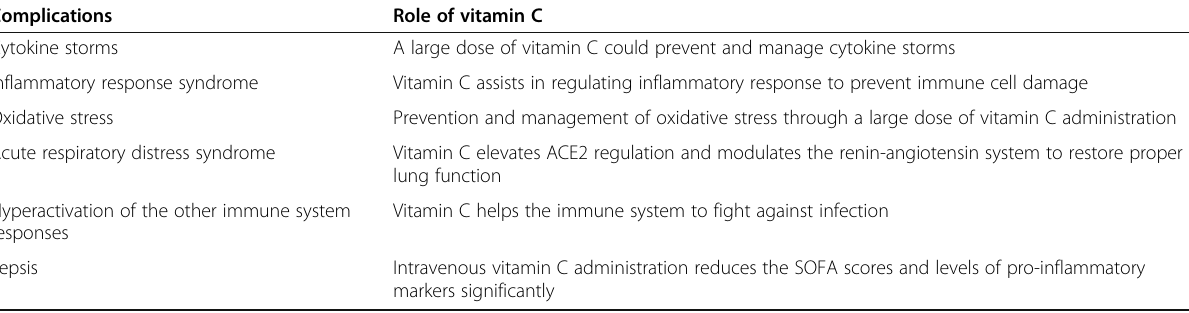
Table 1 Role of vitamin C in the modulation of several complications [69] Complications Role of vitamin